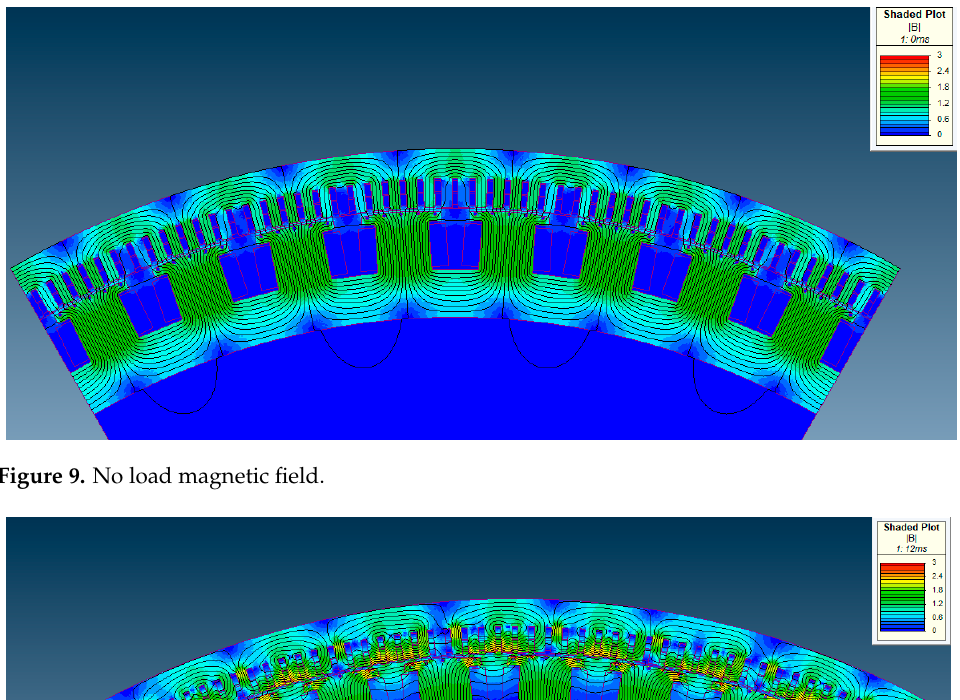
Figure 9. No load magnetic field.